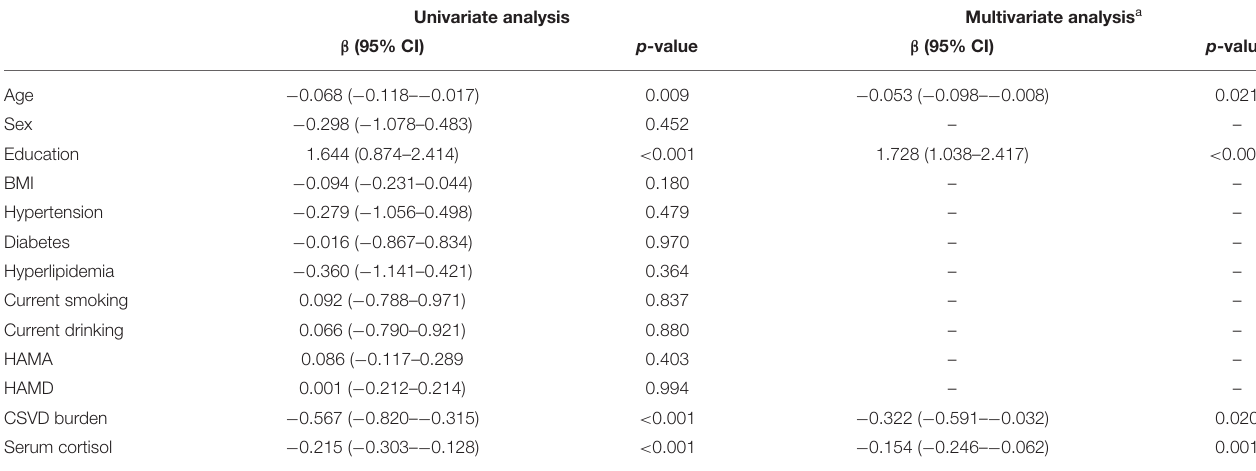
TABLE 3 | Multiple linear regression analyses between serum cortisol levels and MoCA scores.